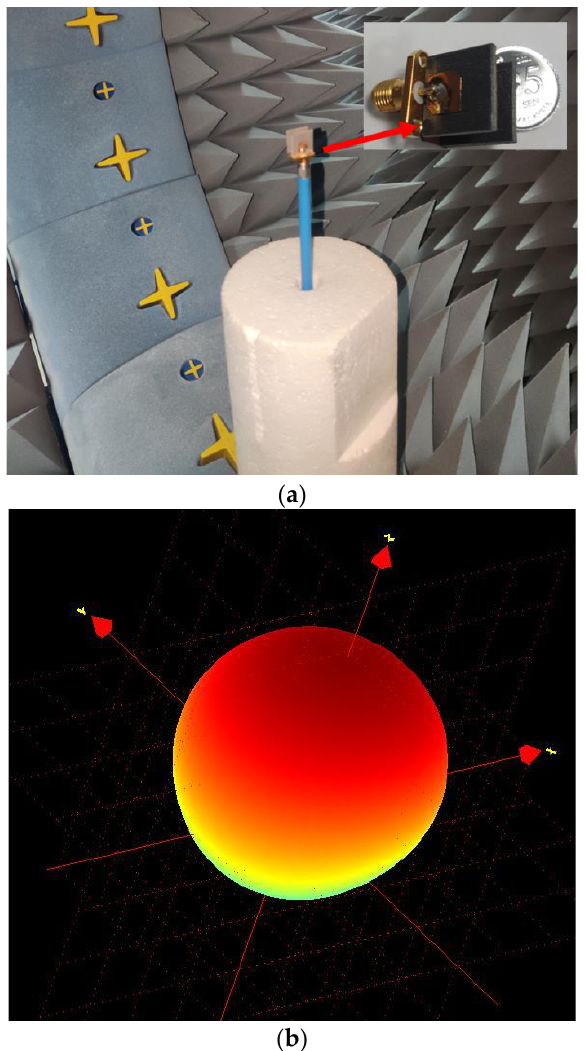
Figure 5. The radiation pattern of the antenna ( a ) measurement system and ( b ) measured radiation pattern.